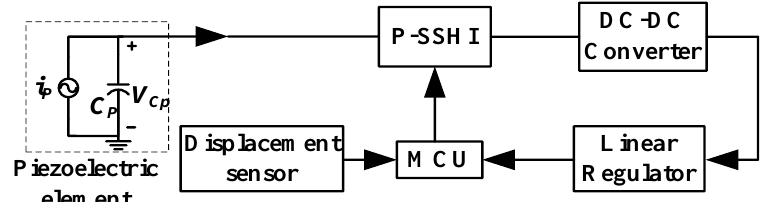
Figure 1. System topology. P-SSHI: parallel synchronized switch harvesting on inductor interface circuit; MCU: microcontroller.